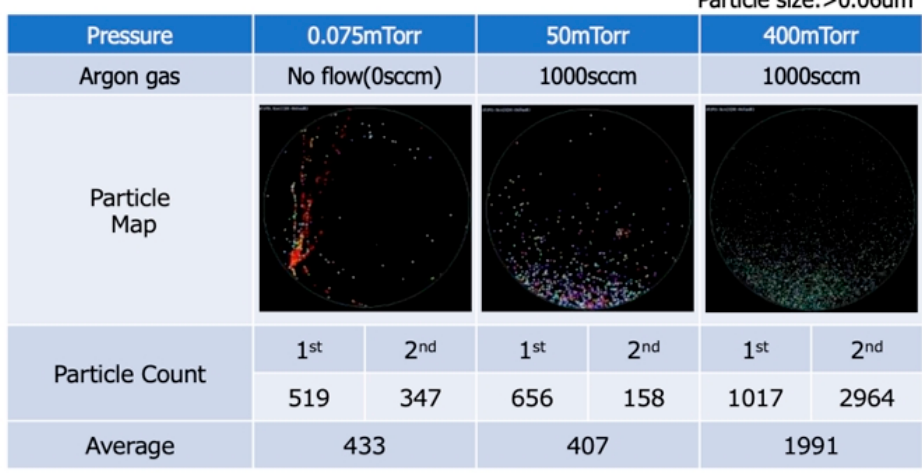
Figure 11. Particle flow distributions under different gas flow rates and chamber pressures.